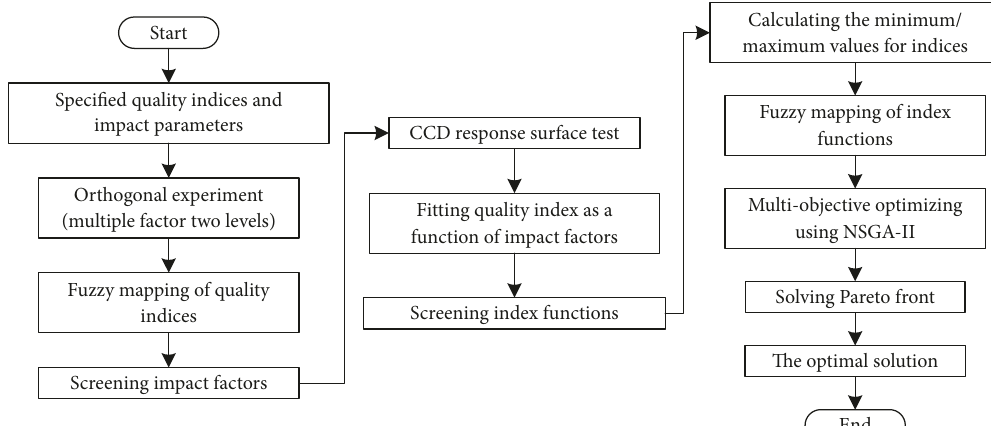
Figure 4: Solving process of the optimization method.